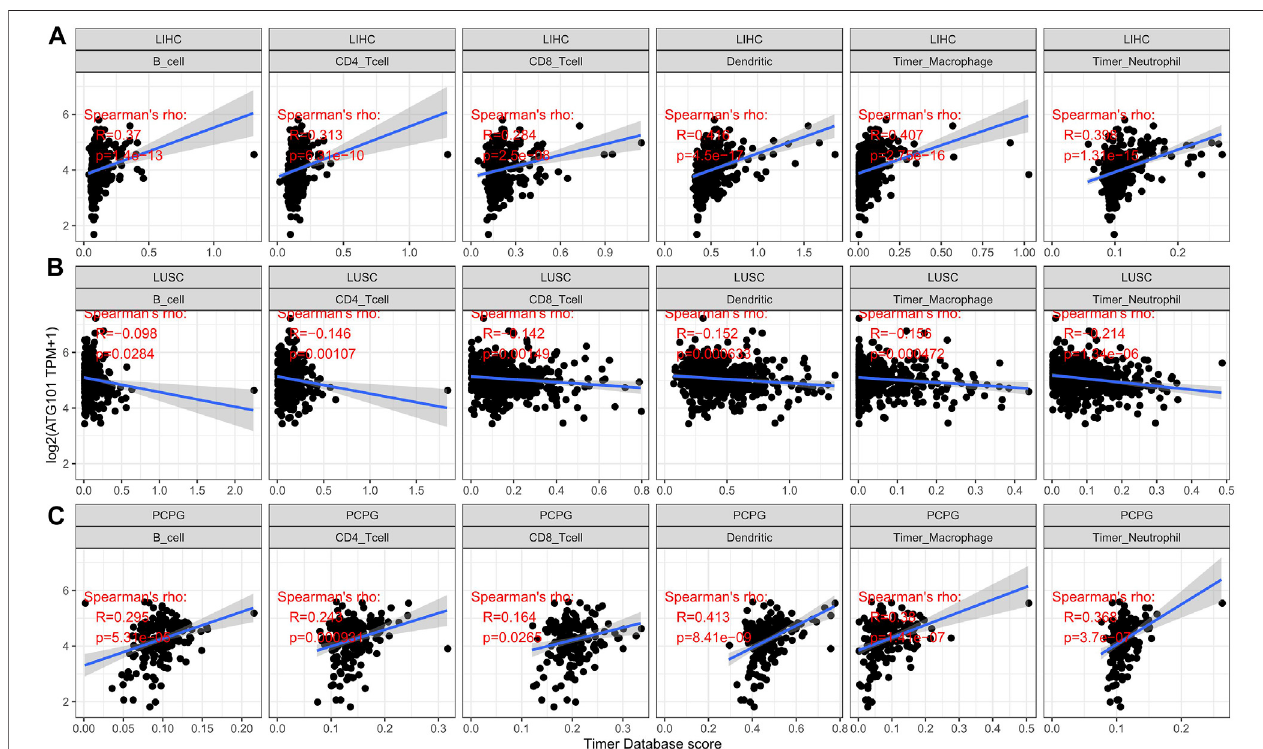
FIGURE3| Therelationshipbetween theexpression levelofATG101 andthein fi ltrationlevelofsixkinds ofimmunecellsinpatientswithmalignant tumours. (A – C) The three tumours, LIHC, LUSC and PCPG, respectively, with the strongest correlation with immune cell in fi ltration.